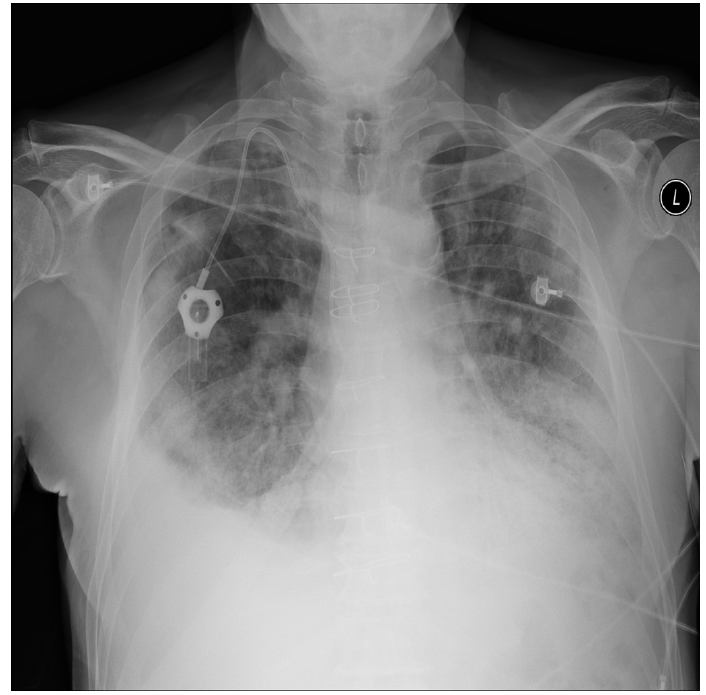
Figure 12. Pneumonia sample: